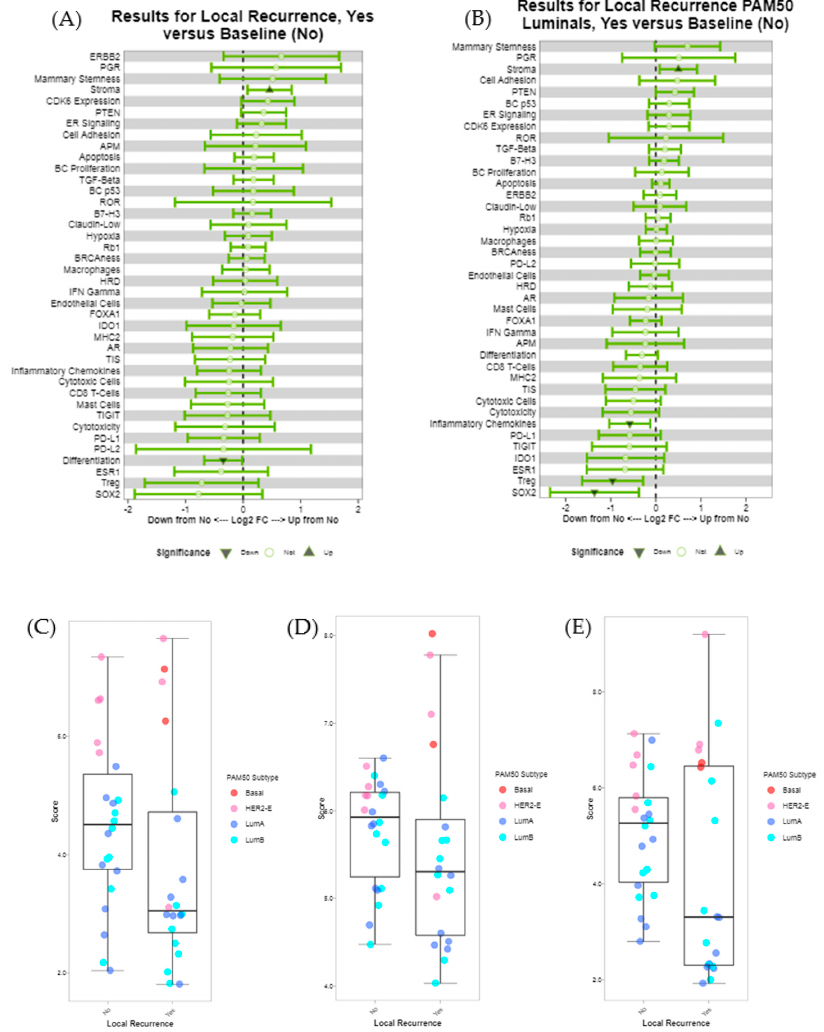
Figure 5. Forest plot of gene expression signatures using the NanoString BC360 panel. ( A ) Forest plot of BC360 signatures for IHC luminal cases. ( B ) Forest plot of BC360 signatures for PAM50 luminal cases. ( C ) Boxplot of Treg scores for all IHC luminal cases, coloured by PAM50 subtype. ( D ) Boxplot of inflammatory chemokines for all IHC luminal cases, coloured by PAM50 subtype. ( E ) Boxplot of SOX2 for all IHC luminal cases, coloured by PAM50 subtype.